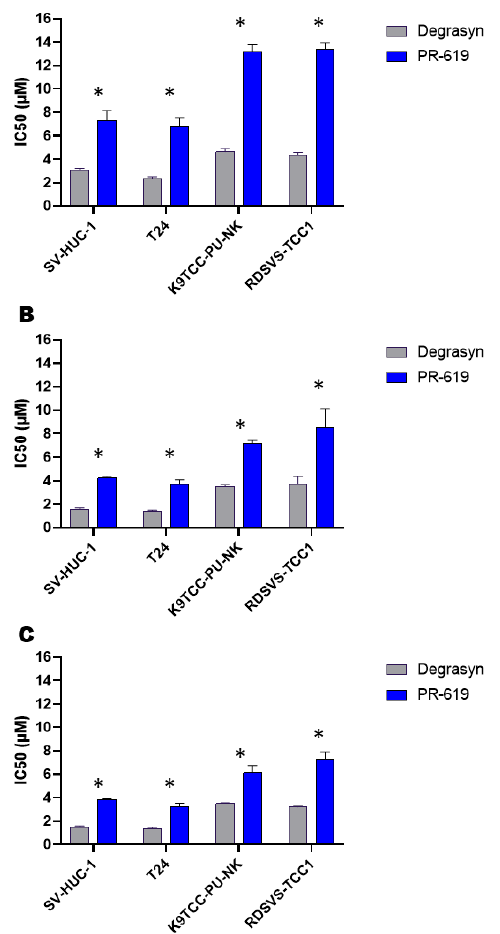
Figure 2. Comparison of Degrasyn and PR-619 half maximal inhibitory concentrations (IC 50 ) values after ( A ) 24 h incubation; ( B ) 48 h incubation; ( C ) 72 h incubation. The values are presented as means ± standard deviations (SD) of three independent experiments. * Difference between Degrasyn and PR-619 considered statistically significant ( p < 0.05).